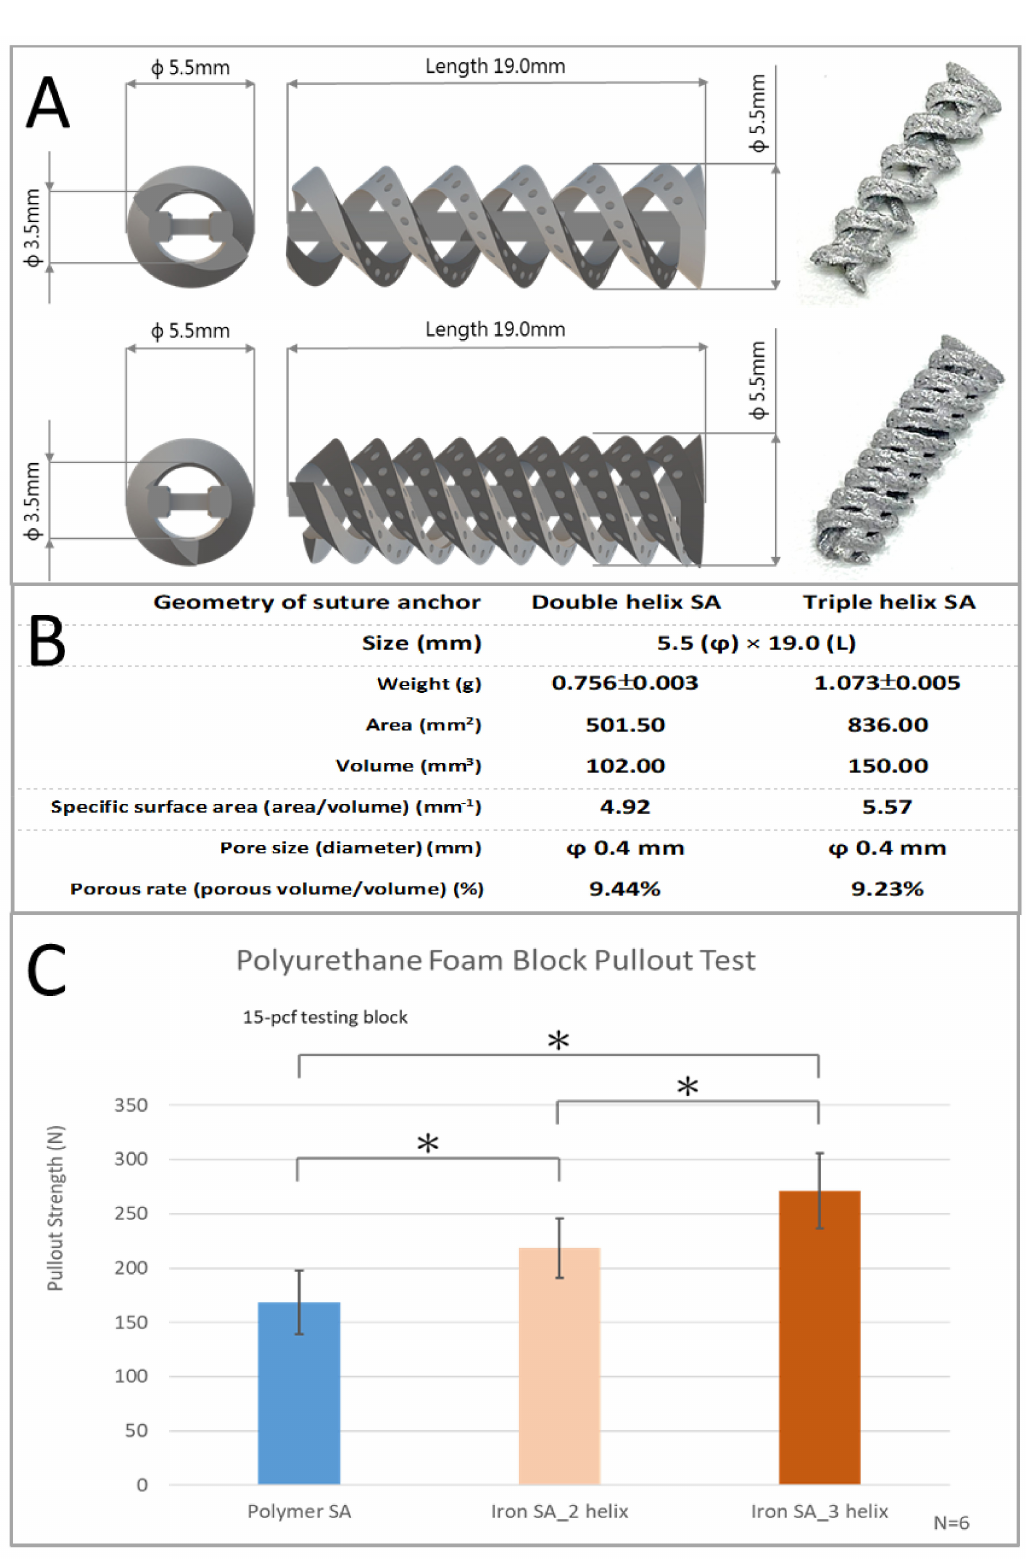
Figure 1. Illustration of iron-based bioabsorbable porous double- and triple-helical suture anchors ( A ). Geometrical specifications of iron-based bioabsorbable porous double- and triple-helical suture anchors ( B ). In vitro mechanical ultimate pullout strength test of three types of suture anchors ( C ). The error bar represents the standard deviation, and * denotes statistical significance between the two